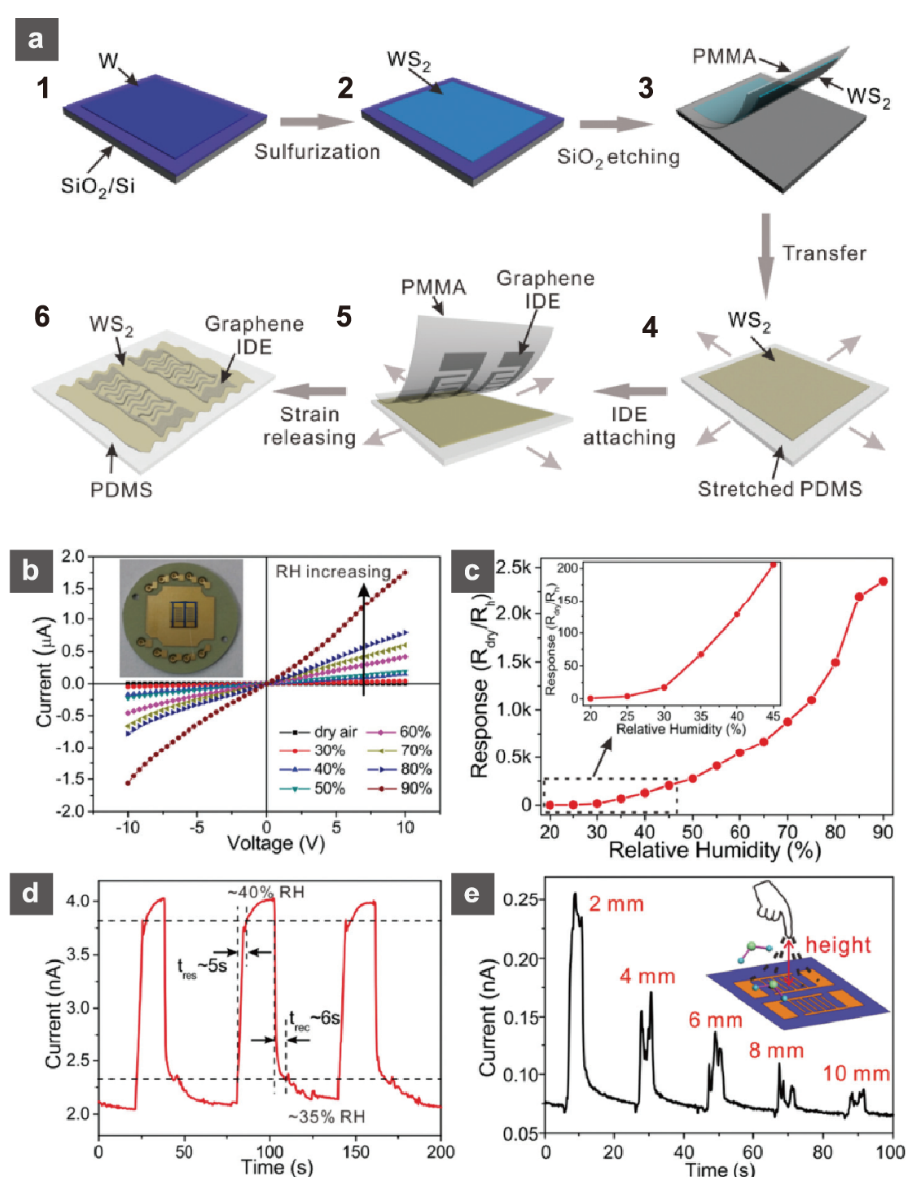
Figure 7. ( a ) Schematic of the device fabrication process. Humidity sensing properties of the WS 2 film on the SiO 2 /Si substrate. ( b ) Current–voltage (I–V) characteristics in different relative humidities. Inset: Image of a rigid WS 2 sensor connected to the sample stage by wire bonding. ( c ) Response of the sensor at different relative humidities (RHs). ( d ) Time-dependent response current of three cycles of humidity switching between the low RH level (35%) and high RH level (40%). ( e ) Time-dependent response current with a fingertip vertically approaching and retracting away from the device surface at different distances. The RH of the test environment is about 40%. The RH near the finger is about 43%. Reprinted with permission from Ref. [72]. Copyright 2017 Royal Society of Chemistry.